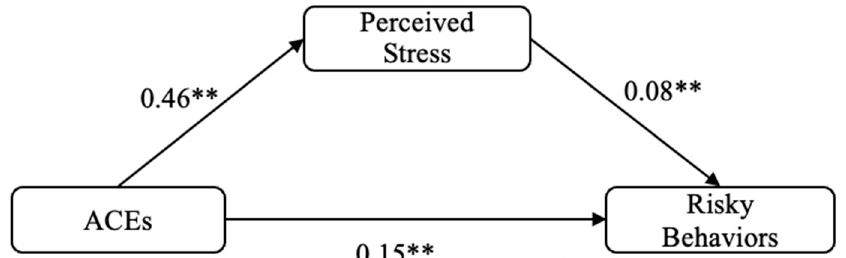
Figure 1. Mediation analysis model linking ACEs to risky behaviors through perceived stress. ** p < 0.01.